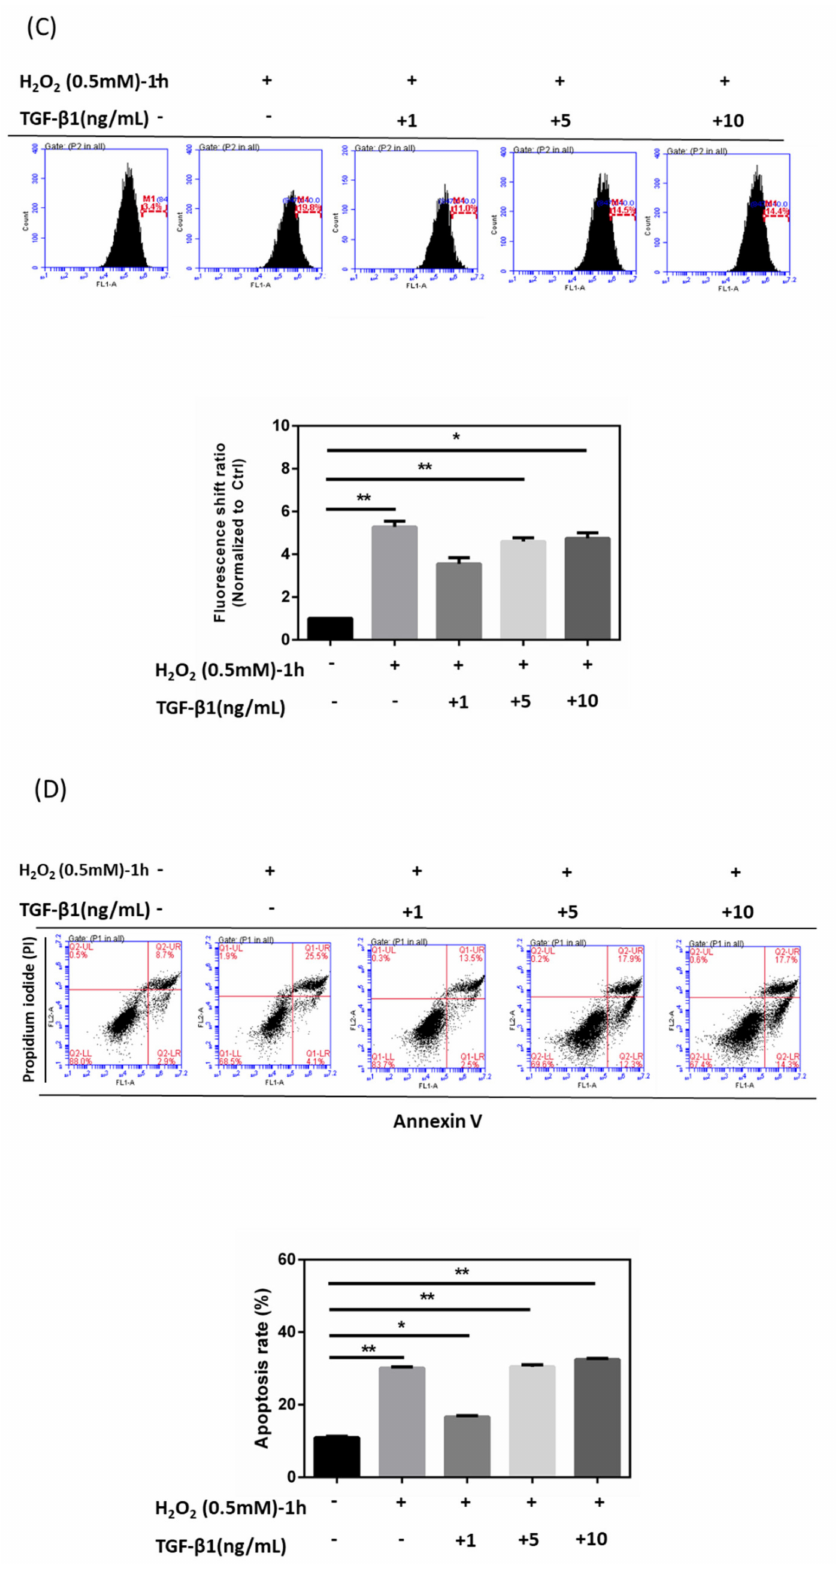
Figure 4. Effects of rhTGF- β 1 protein during oxidative stress response of HTMCs. ( A ) Levels of ROS intensity in HTMCs with rhTGF- β 1 pretreatment at different concentrations (1, 5, 10 ng/mL) combined with H 2 O 2 treatment (0.5 mM) for 1 h. Data on rhTGF- β 1 (1 ng/mL) pretreatment with H 2 O 2 showed lower intracellular ROS and indicated protective effects. Histogram values reflect